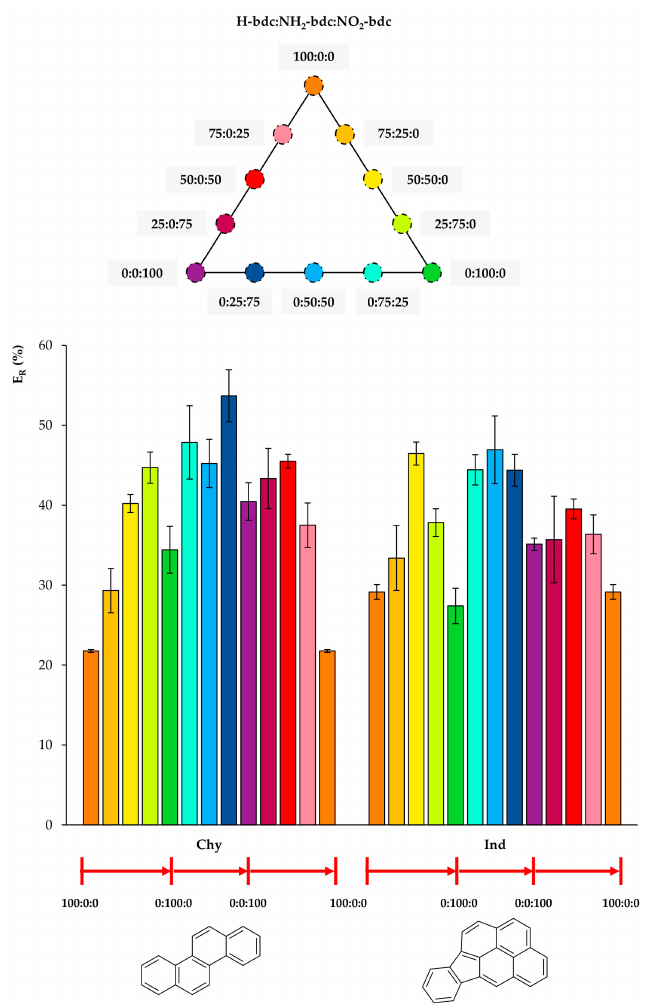
Figure 6. Extraction e ffi ciencies (E R in %) using the twelve UiO-66-based MOFs as sorbents in D- µ SPE-HPLC-DAD for the analytes chrysene (Chy) and indeno(1,2,3-cd)pyrene (Ind) (selected